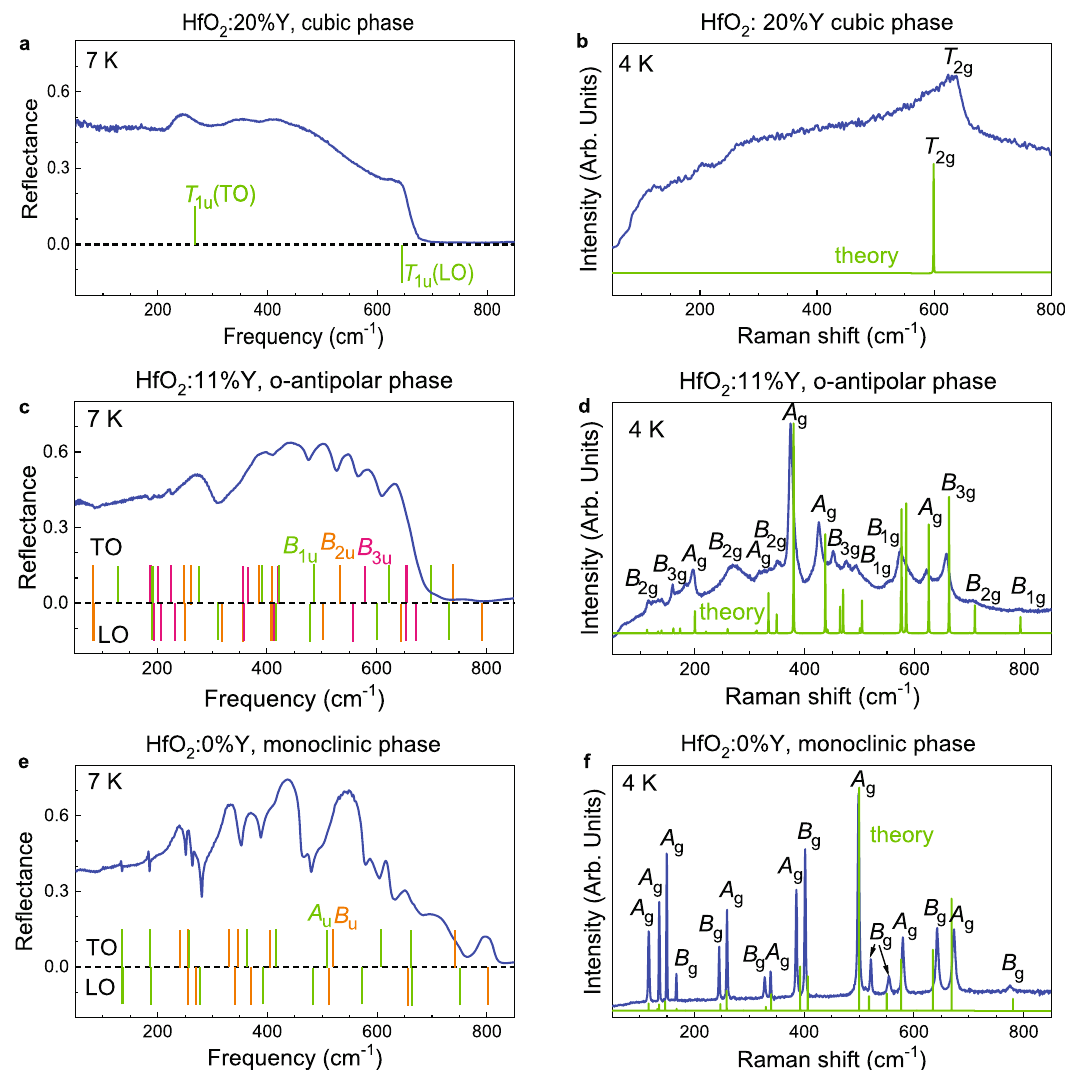
Fig. 2 Infrared and Raman responses of the cubic, orthorhombic-antipolar, and monoclinic phases of HfO 2 . a Infrared re fl ectance spectrum of cubic HfO 2 :20%Y at 7 K. b Raman spectrum of cubic HfO 2 :20%Y at 4 K. c Infrared re fl ectance spectrum of o-AP HfO 2 :11%Y at 7 K. d Raman spectrum of o-AP HfO 2 :11%Y at 4 K. e Infrared re fl ectance spectrum of monoclinic HfO 2 at 7 K. f Raman spectrum of monoclinic HfO 2 at 4 K. The calculated Raman response of pure HfO 2 is plotted along with the measured spectrum in green. The theoretical peak positions of the infrared TO and LO modes in pure stablilizr-free HfO 2 are marked using vertical upward and downward lines, respectively. Details are available in the Supplementary